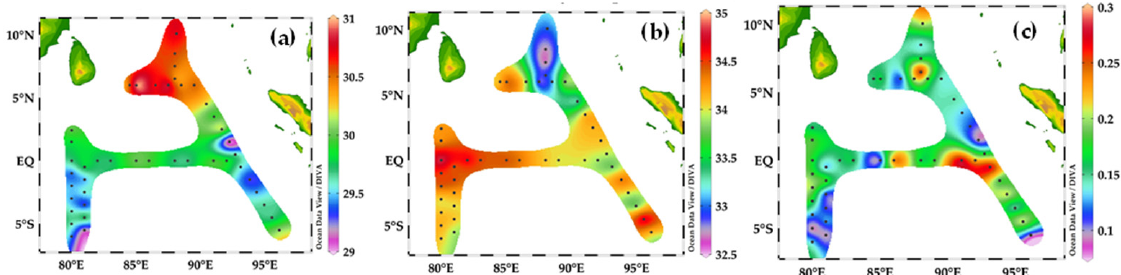
Figure 3. Sea-surface distribution of temperature ( a ), salinity ( b ), and chlorophyll- a concentration ( c ) in the Eastern Indian Ocean. ( a ) The highest value of temperature o C in the BoB sampling station at transect 90° E and the lowest value of temperature o C in the SEQ sampling station at transect 80° E. ( b ) The highest value of salinity in the SEQ sampling station occurs at transect 80° E and the low salinity value occurs at the BoB sampling station at transect 90° E. ( c ) The high value of Chlorophyll- a µg/L in the equatorial region and the BoB sampling sites at the transect 90° E. 3.3. Community Structure and Diversity Pattern A total of 20 planktonic foraminifera species were collected from the study area (Fig- ure 4). The raw data of each species at each station has been described (Supplementary